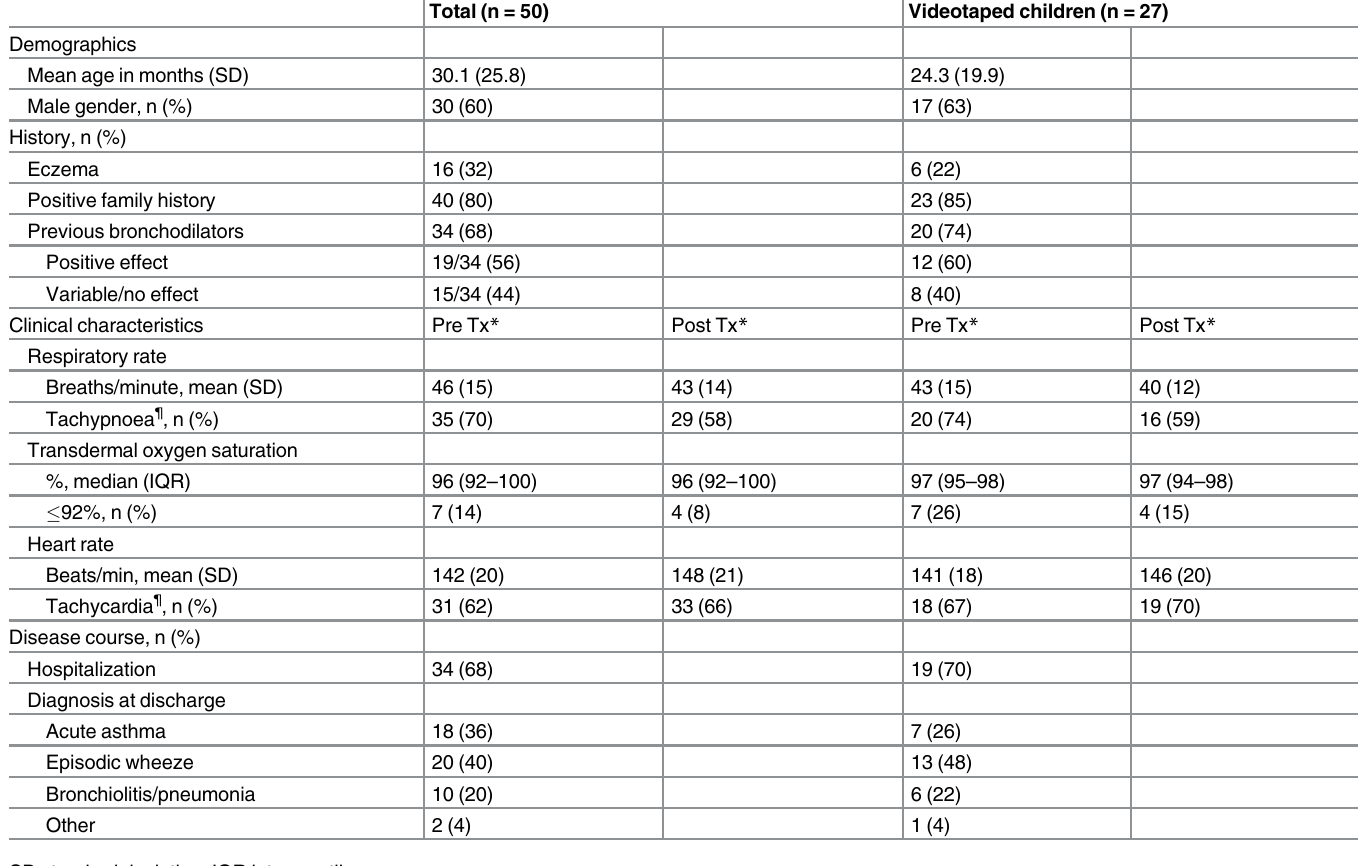
Table 1. Patient characteristics for total group (n = 50) and videotaped participants (n =